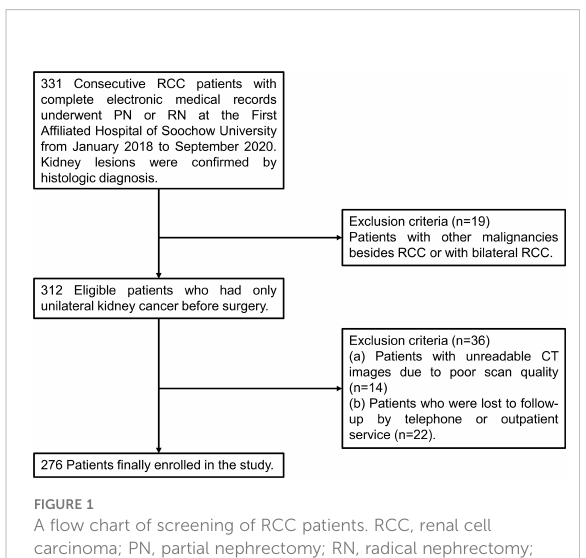
FIGURE 1 A fl ow chart of screening of RCC patients. RCC, renal cell carcinoma; PN, partial nephrectomy; RN, radical nephrectomy; CT, computerized